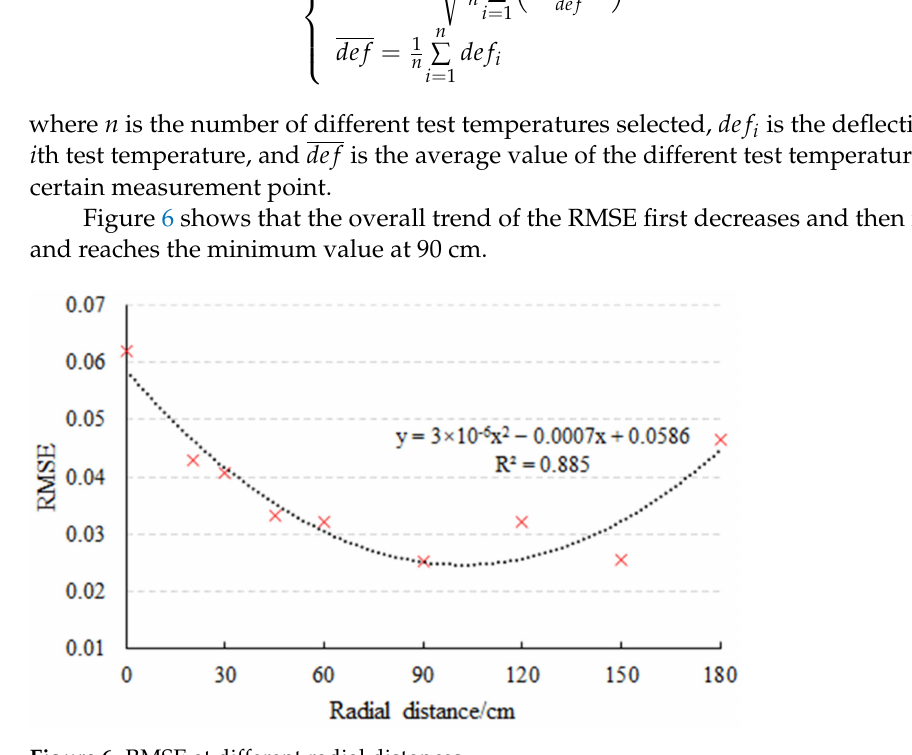
Figure 6. RMSE at different radial